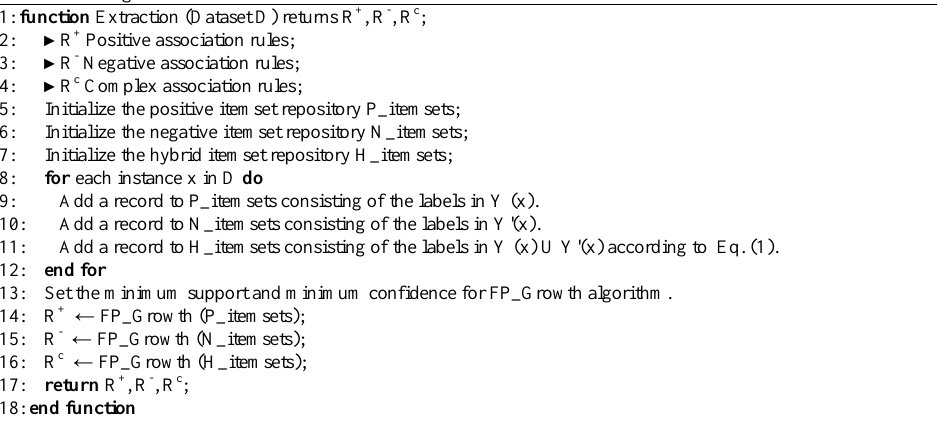
Algorithm 1. Extracting positive, negative, and hybrid association rules from a multi-label dataset by employing FP Growth algorithm.